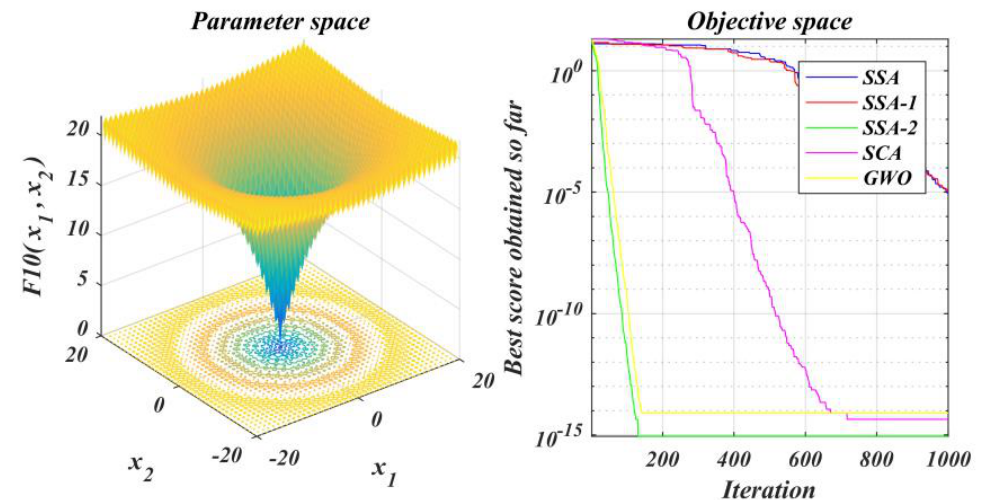
Figure 5. F10 Convergence curve.